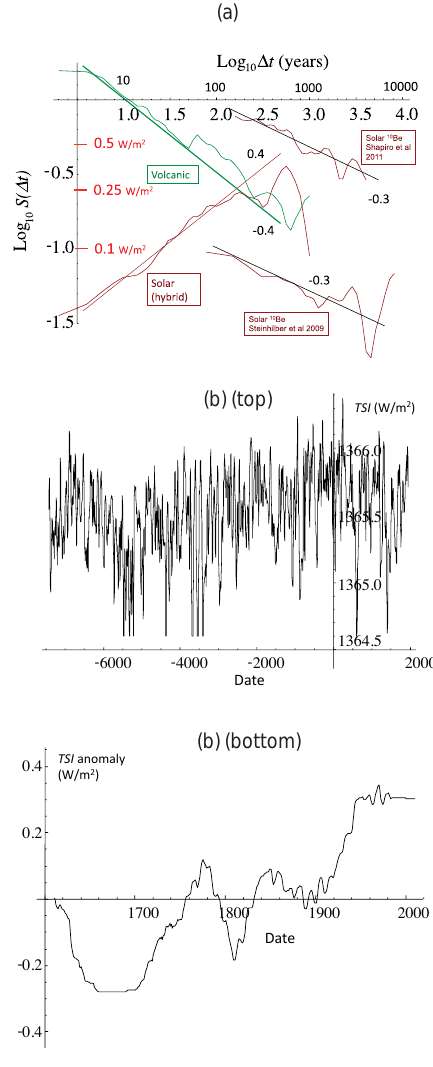
Figure 2. (a) The RMS Haar fluctuation S ( (cid:49)t ) for the solar and volcanic reconstructions used in the ZC simulation for lags (cid:49)t from 2 to 1000 years (left). The solar is a “hybrid” obtained by “splicing” the sunspot-based reconstruction ( b , top) with a 10 Be-based recon- struction ( b , bottom). The two rightmost curves are for two differ- ent 10 Be reconstructions (Shapiro et al., 2011; Steinhilber et al., 2009). Although at any given scale, their different assumptions lead to amplitudes differing by nearly a factor of 10, their exponents are virtually identical and the amplitudes diminish rapidly with scale. (b) A comparison of the sunspot derived total solar irradiance (TSI) anomaly (top, used in the ZC and GISS simulations back to 1610, H ≈ 0.4) with a recent 10 Be reconstruction (bottom, total TSI – mean plus anomaly – since 7362BC; see (a) for a fluctuation anal- ysis, H ≈− 0.3) similar to that “spliced” onto the sunspot recon- struction for the period 1000–1610. We can see that the statistical characteristics are totally different with the sunspot variations “wan- dering” ( H > 0), whereas the 10 Be reconstruction is “cancelling” ( H < 0). The sunspot data were for the “background” (i.e. with no 11-year cycle; see Wang et al., 2005, for details); the data for the 10 Be curve were from Shapiro et al.